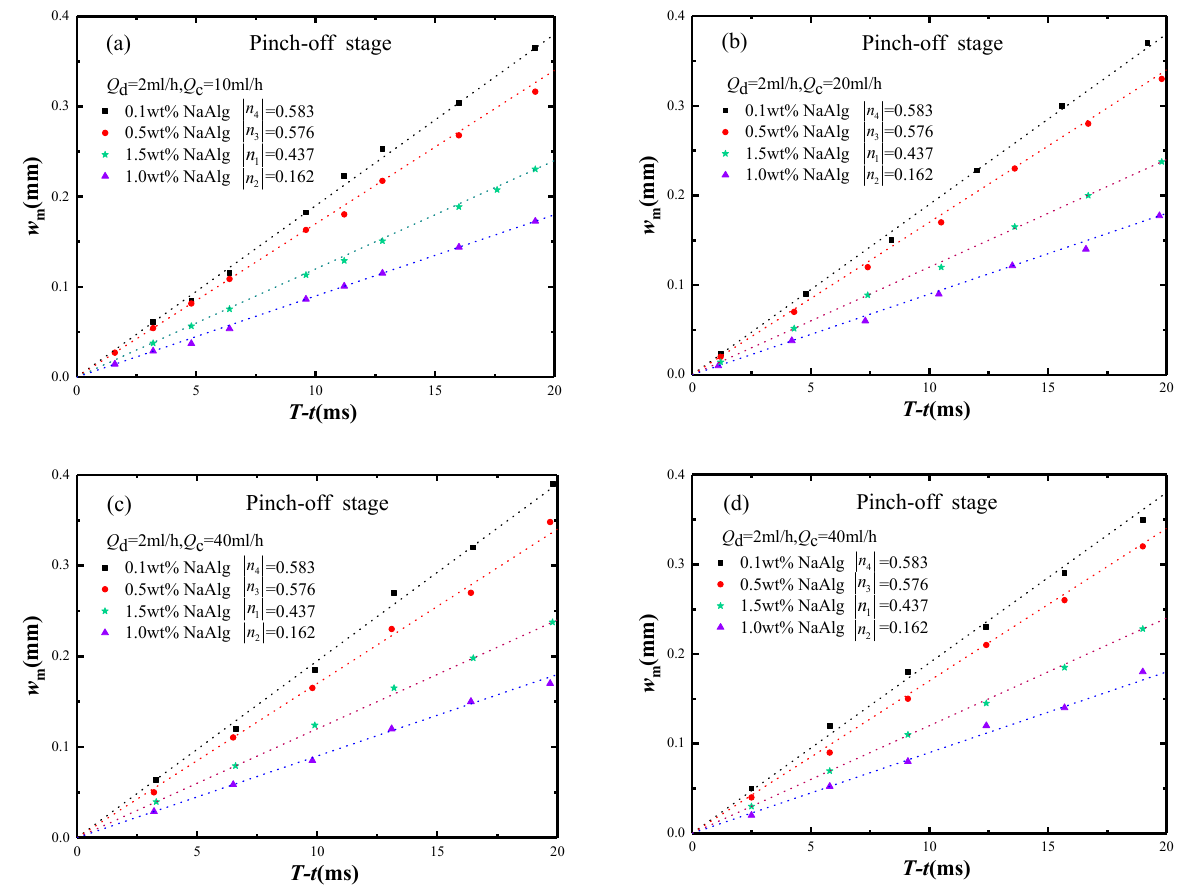
Figure 11. The relationship between w m and T − t with different | n | in the pinch-off stage, ( a ) Q d = 2 mL/h, Q c = 10 mL/h, ( b ) Q d = 2 mL/h, Q c = 20 mL/h, ( c ) Q d = 2 mL/h, Q c = 40 mL/h and ( d ) Q d = 2 mL/h, Q c = 100 mL/h.